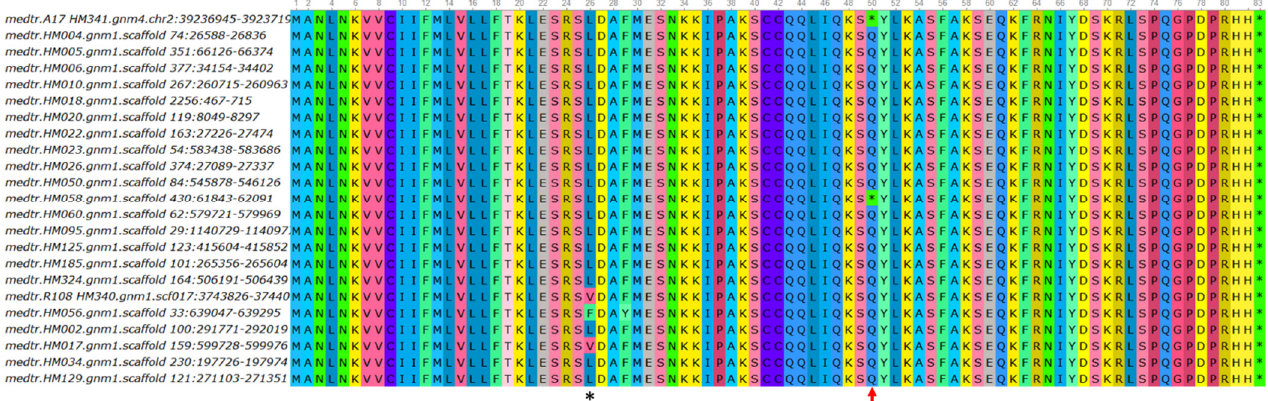
Figure 3. The alignment of amino acid sequences of the MtCLE34 protein product from 23 M. truncatula accessions from HAPMAP2 Medicago database. The position of the stop codon found in the A17 and HM058 lines is marked with a red arrow. Asterisk marks variable position at the 26th amino acid residue.